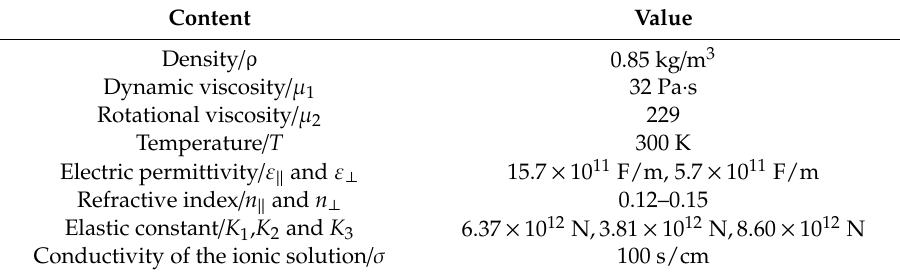
Table 1. Construction parameters of the liquid crystal.